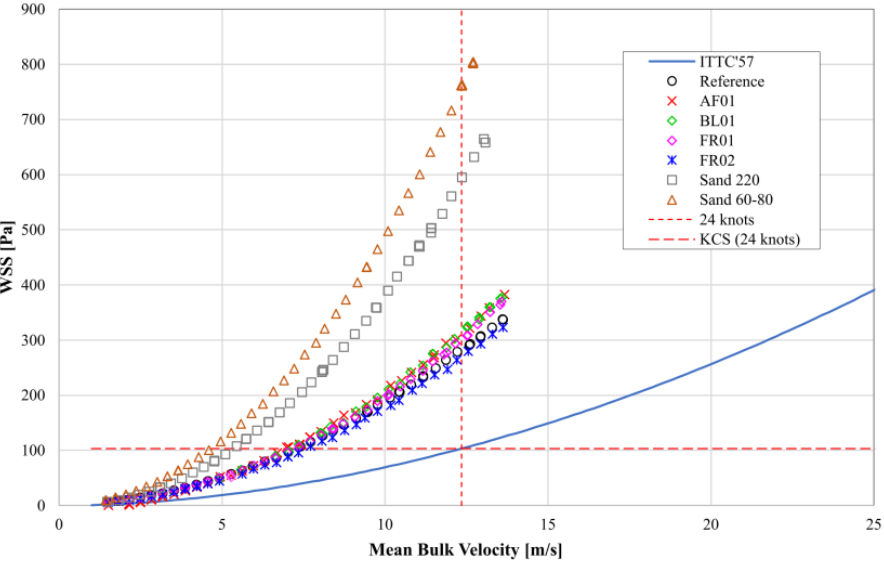
Figure 7. Wall shear stress achieved in FTFC compared to a 232.5 m long flat plate using the ITTC formulation.